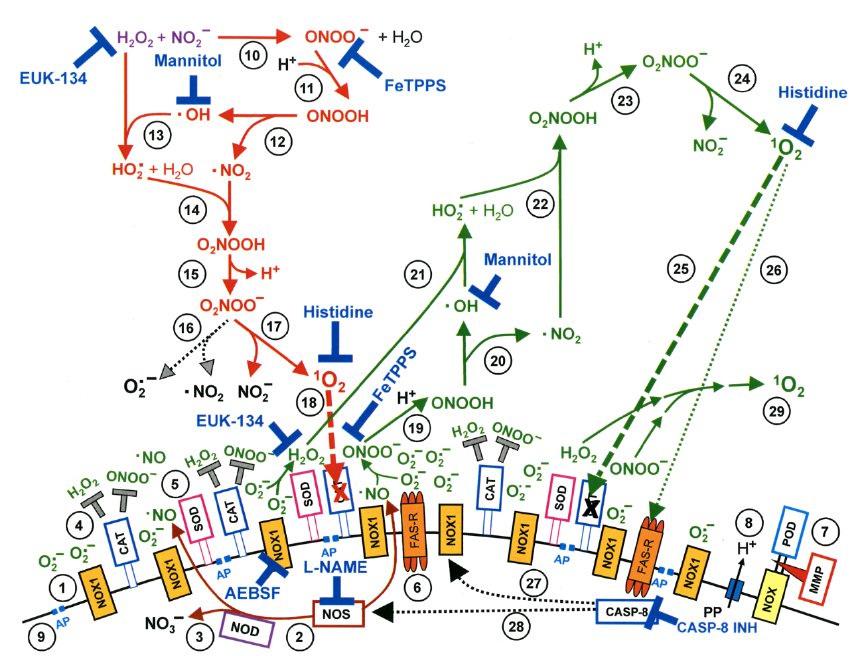
Figure 2. Interactions between CAP components and cell surface that trigger cell apoptosis through generating primary and secondary singlet oxygen ( 1 O 2 ). NADPH oxidase 1 (NOX1) is expressed in the membrane of tumor cells and generates extracellular superoxide anions (O ·